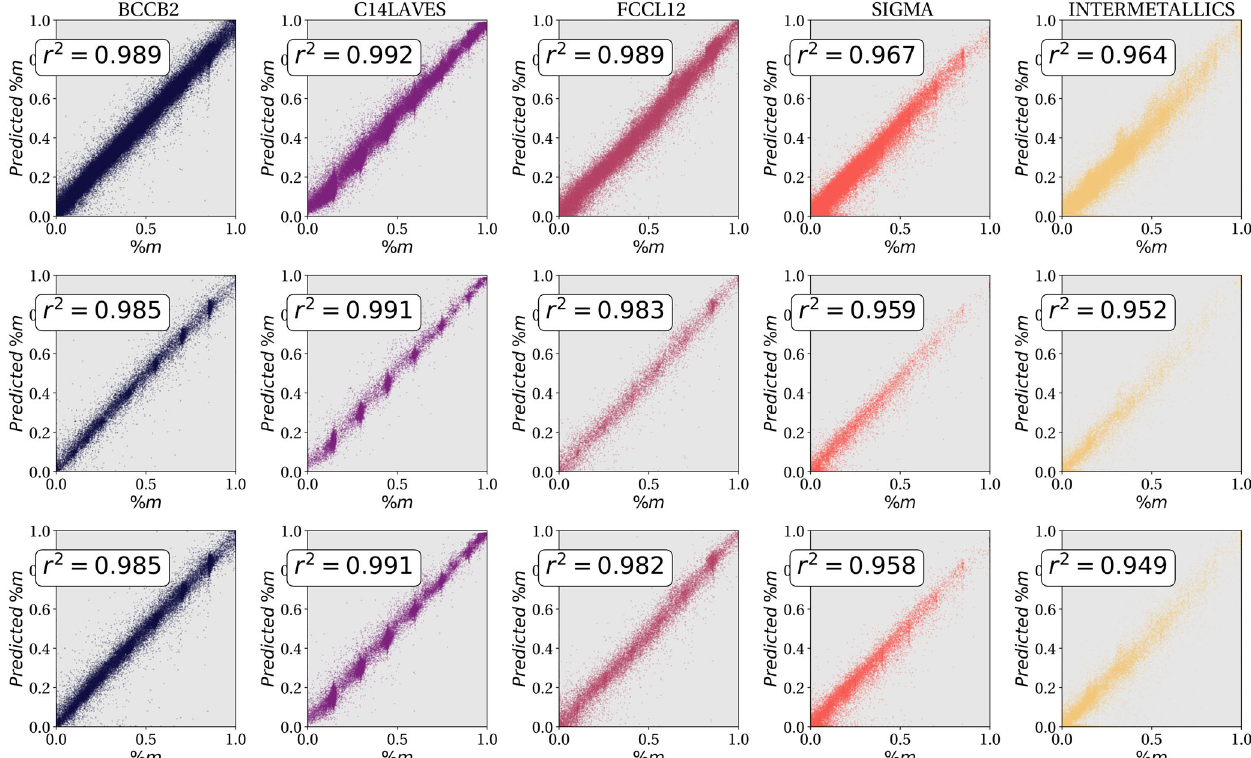
Fig. 4 DNN ’ s prediction results for each data subset. Parity-plot for Predicted vs Calculated phase fraction for the training (top row), validation (middle row), and testing (bottom